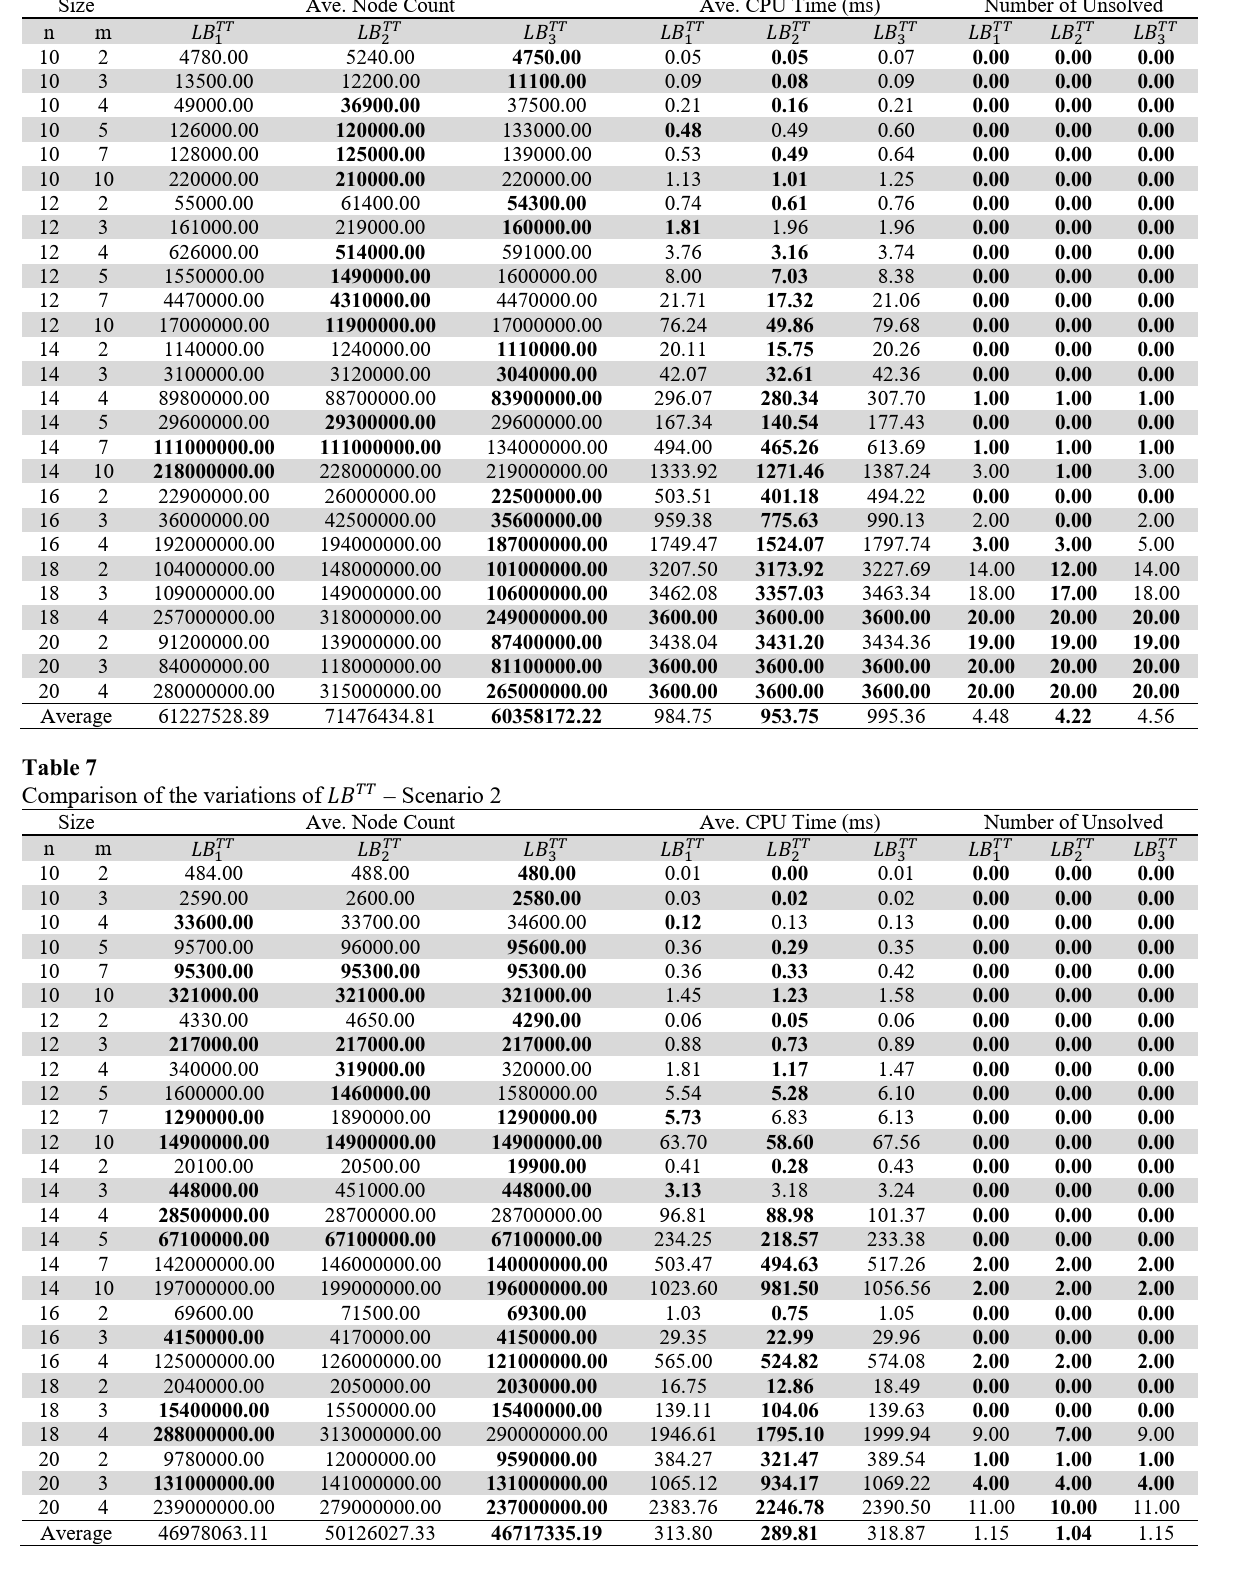
Table 6 Comparison of the variations of 𝐿𝐵 (cid:3021)(cid:3021) – Scenario 1